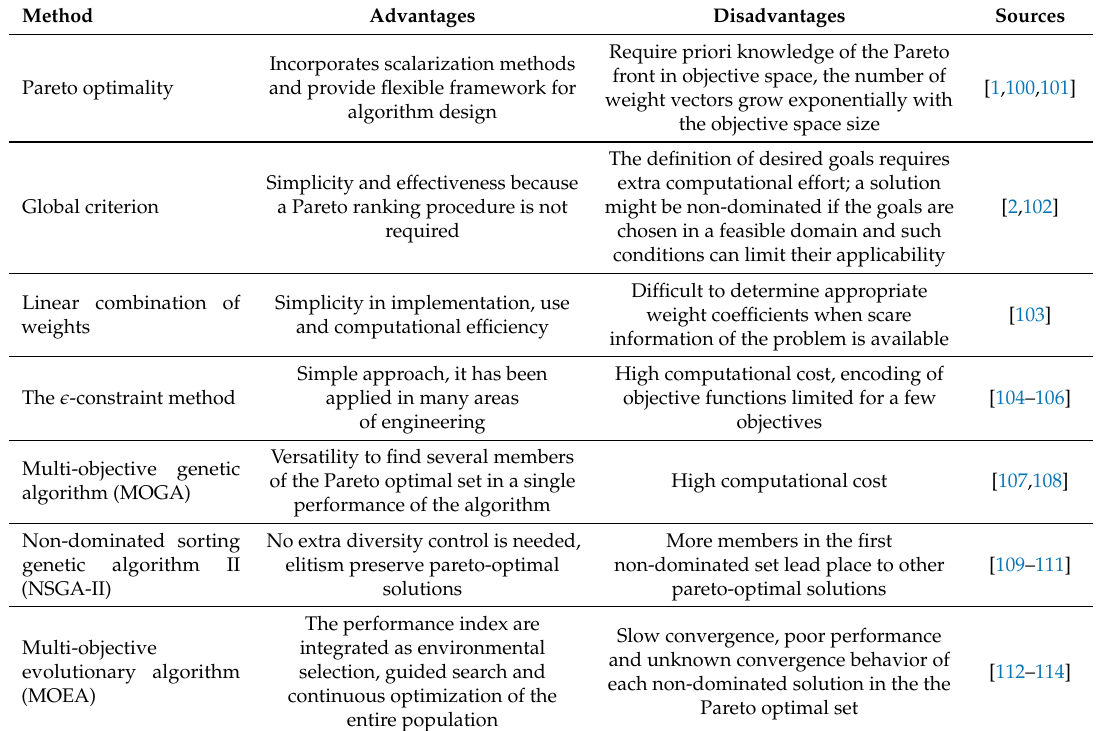
Table 3. Multi-objective optimization